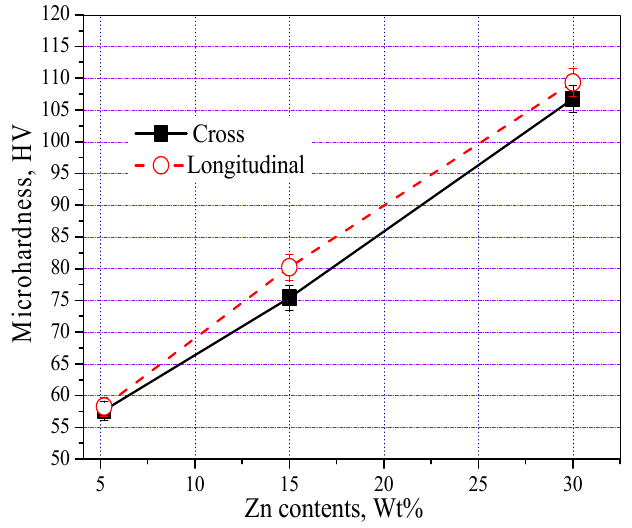
Figure 9. Microhardness of the LAMed Mg-Zn-Zr alloys.